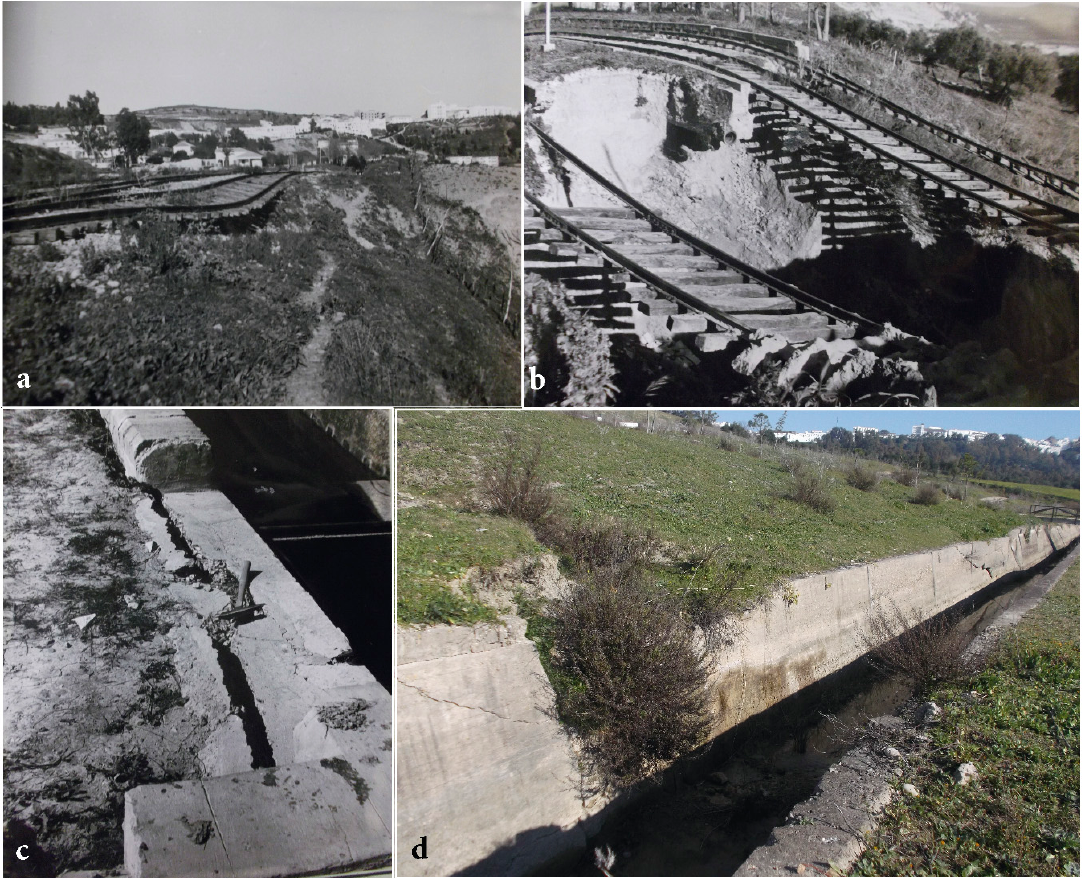
Figure 4. ( a , b ) Damaged railroad close to the old railway station [40]. The slope was affected by numerous landslides in the weathered layer of the GBM. ( c ) Detail of a crack presented in the Tablellina irrigation water channel, located in the low part of the slope [40]. ( d ) Cracks and bulks in the Tablellina water channel in 2015. The location of the photographs is labelled in Figure 1.